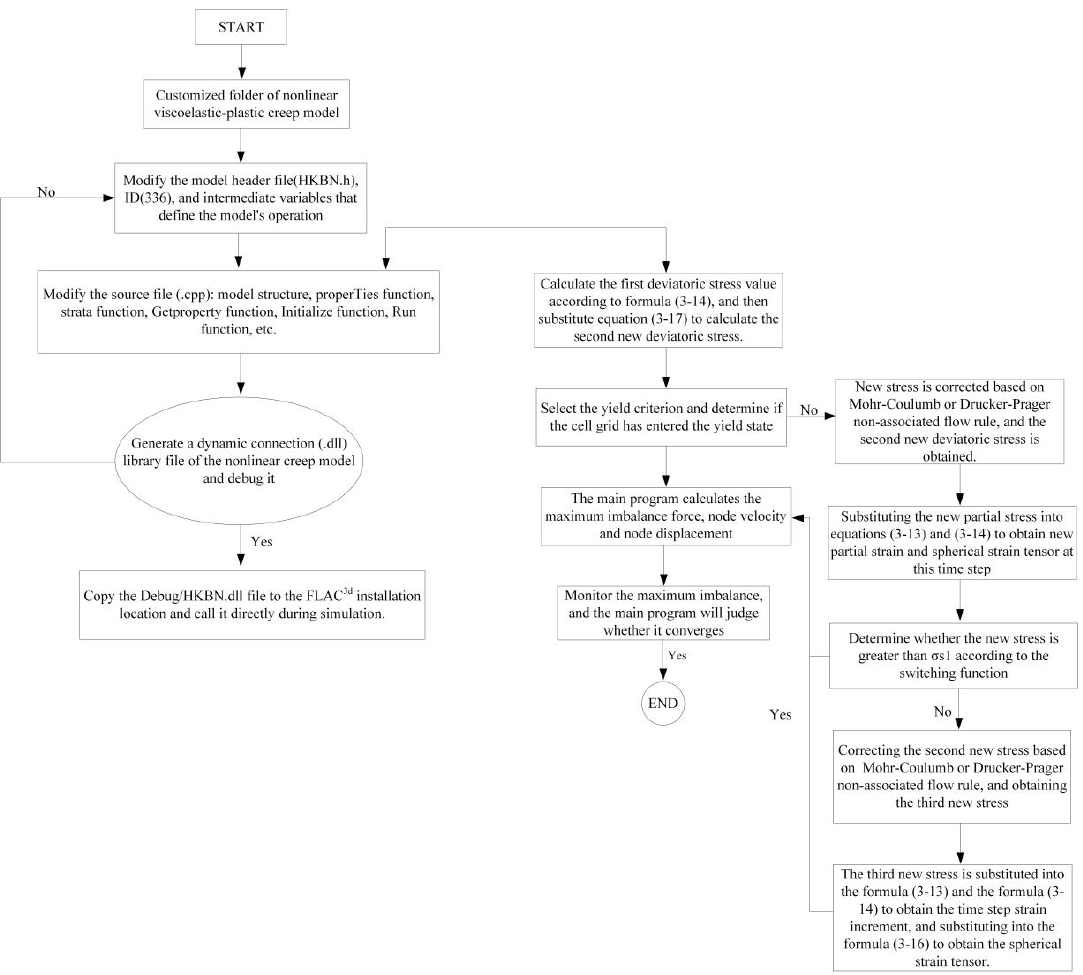
Figure 11. Flow chart of the numerical implementation process for the nonlinear creep model of